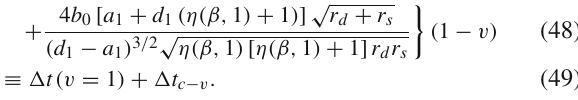
Fig. 2 The partition of the parameter space spanned by M / r s , d and β . The regions (A) and (B) are separated by curve β ≈ √ b 0 / r s , d . The relation b 0 / M 2 (cid:2) O ( 1 ) is implicitly and (C) by β ≈